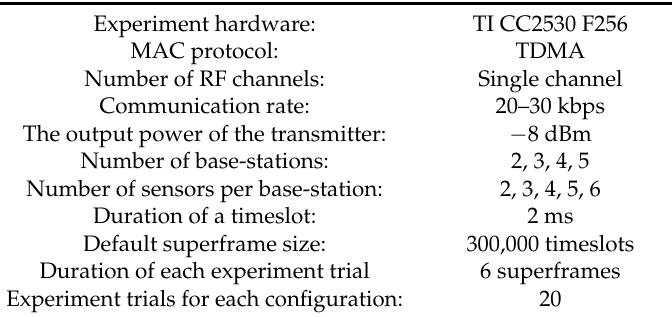
Table 1. Experiment settings.